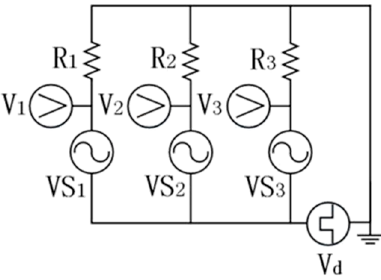
Figure 9. The control circuit of PWM inverter-circuit power supply. Figure 8. The control circuit of three-phase inverter-circuit power supply. Figure 8. The control circuit of three-phase inverter-circuit power supply.